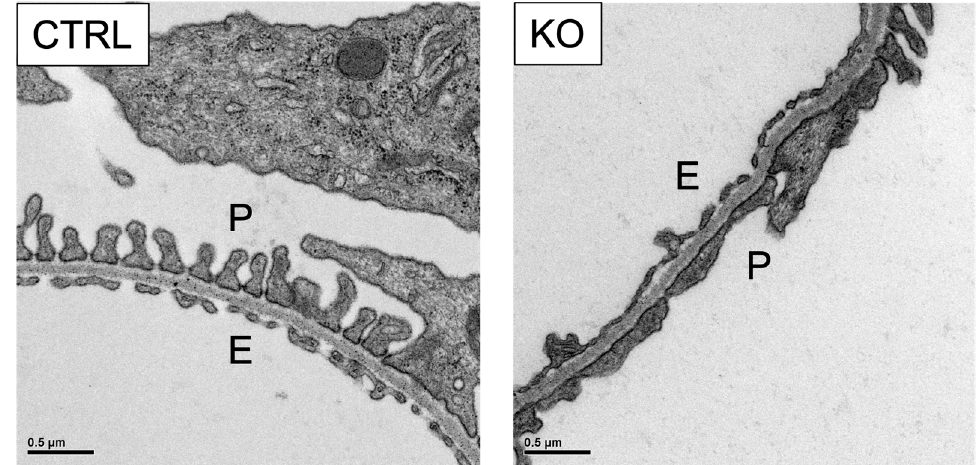
Figure 2. Numbers of foot processes were reduced in the glomeruli of the COUP-TFII knockout mice. CTRL control; KO, COUP-TFII knockout; P, outer side of the glomeruli where podocytes reside; E, endothelial side. Unpublished data.